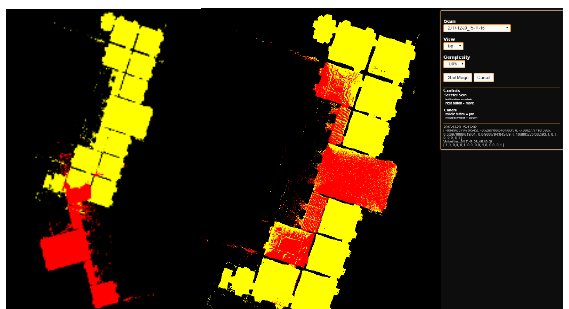
Figure 7. The merge process function in the GeoSLAM Hub